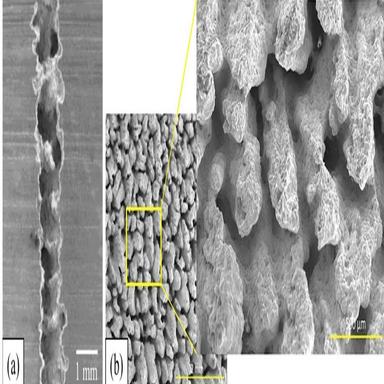
(a) Advanced stage of WDE on flat Ti-6Al-4V specimen tested with whirling arm rig ; (b) steam erosion on the side of ex-service steam turbine blade .